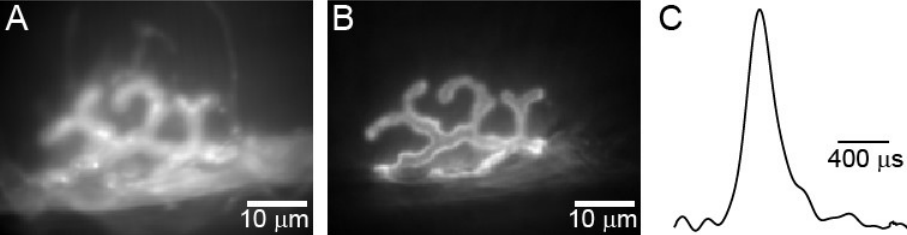
Figure 1. The presynaptic AP waveform at the mouse NMJ is very brief. ( A ) BeRST 1 dye-stained image of a mammalian presynaptic motor nerve terminal. ( B ) Alexa Fluor 488 α-BTX stained image of the same terminal as in A. ( C ) normalized spline of the average presynaptic AP waveform recorded from 11 mouse motor nerve terminals. Adapted from Ojala et al. [26].